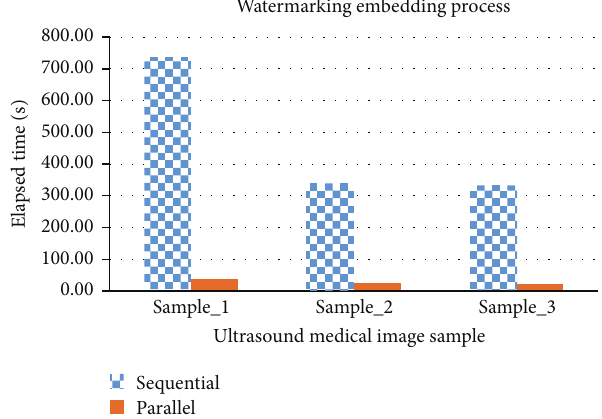
Figure 10: Sequential versus parallel watermarking embedding process in elapsed